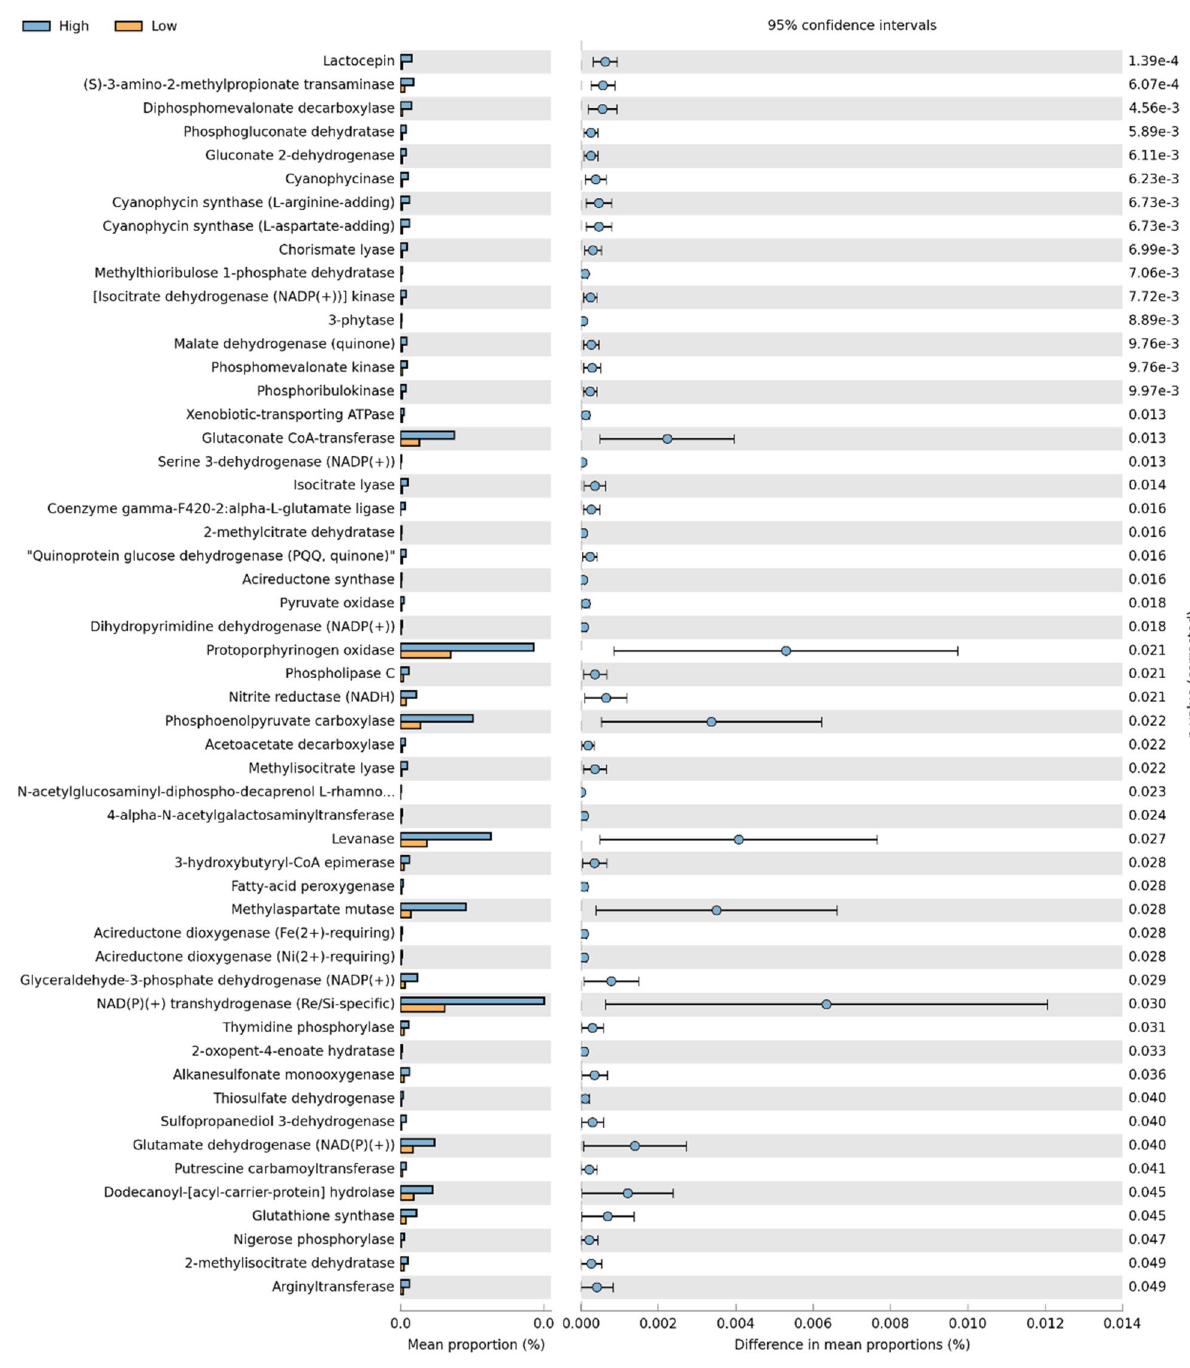
Figure 5. Significantly altered predicted functional KEGG enzymes at level 3 between high and low screen time groups. Single features displayed with q value, effect size, and 95% CI (Welch’s t -test, q < 0.05). Corrected p values ( q ) were calculated using Storey’s FDR